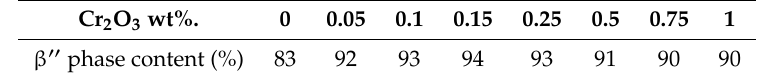
Table 2. The β (cid:48)(cid:48) -Al 2 O 3 phase contents of the sinters for di ff erent amounts of Cr 2 O 3 doping.